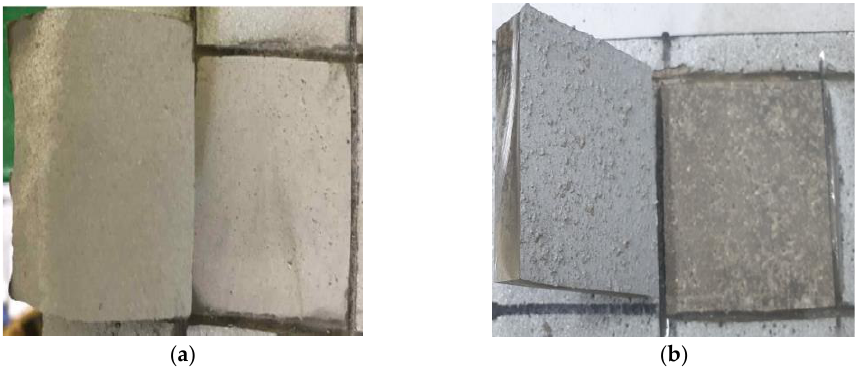
Figure 8. Interfacial failure mode according to surface treatment conditions. ( a ) Control; ( b ) SH.